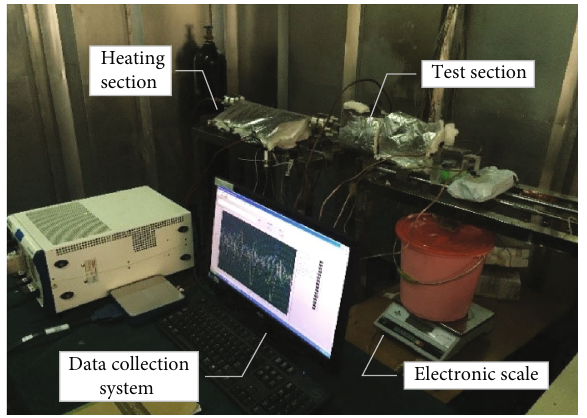
Figure 8: Experimental system.